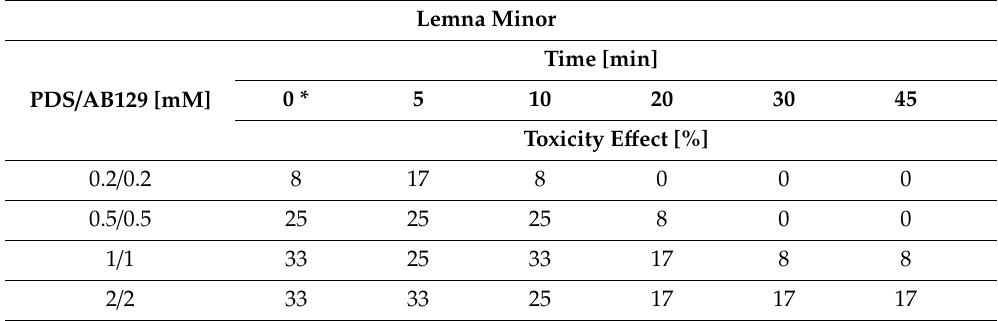
Table 4. Toxicity of AB129 by-products on Lemna minor (* Time 0 min = samples without PDS